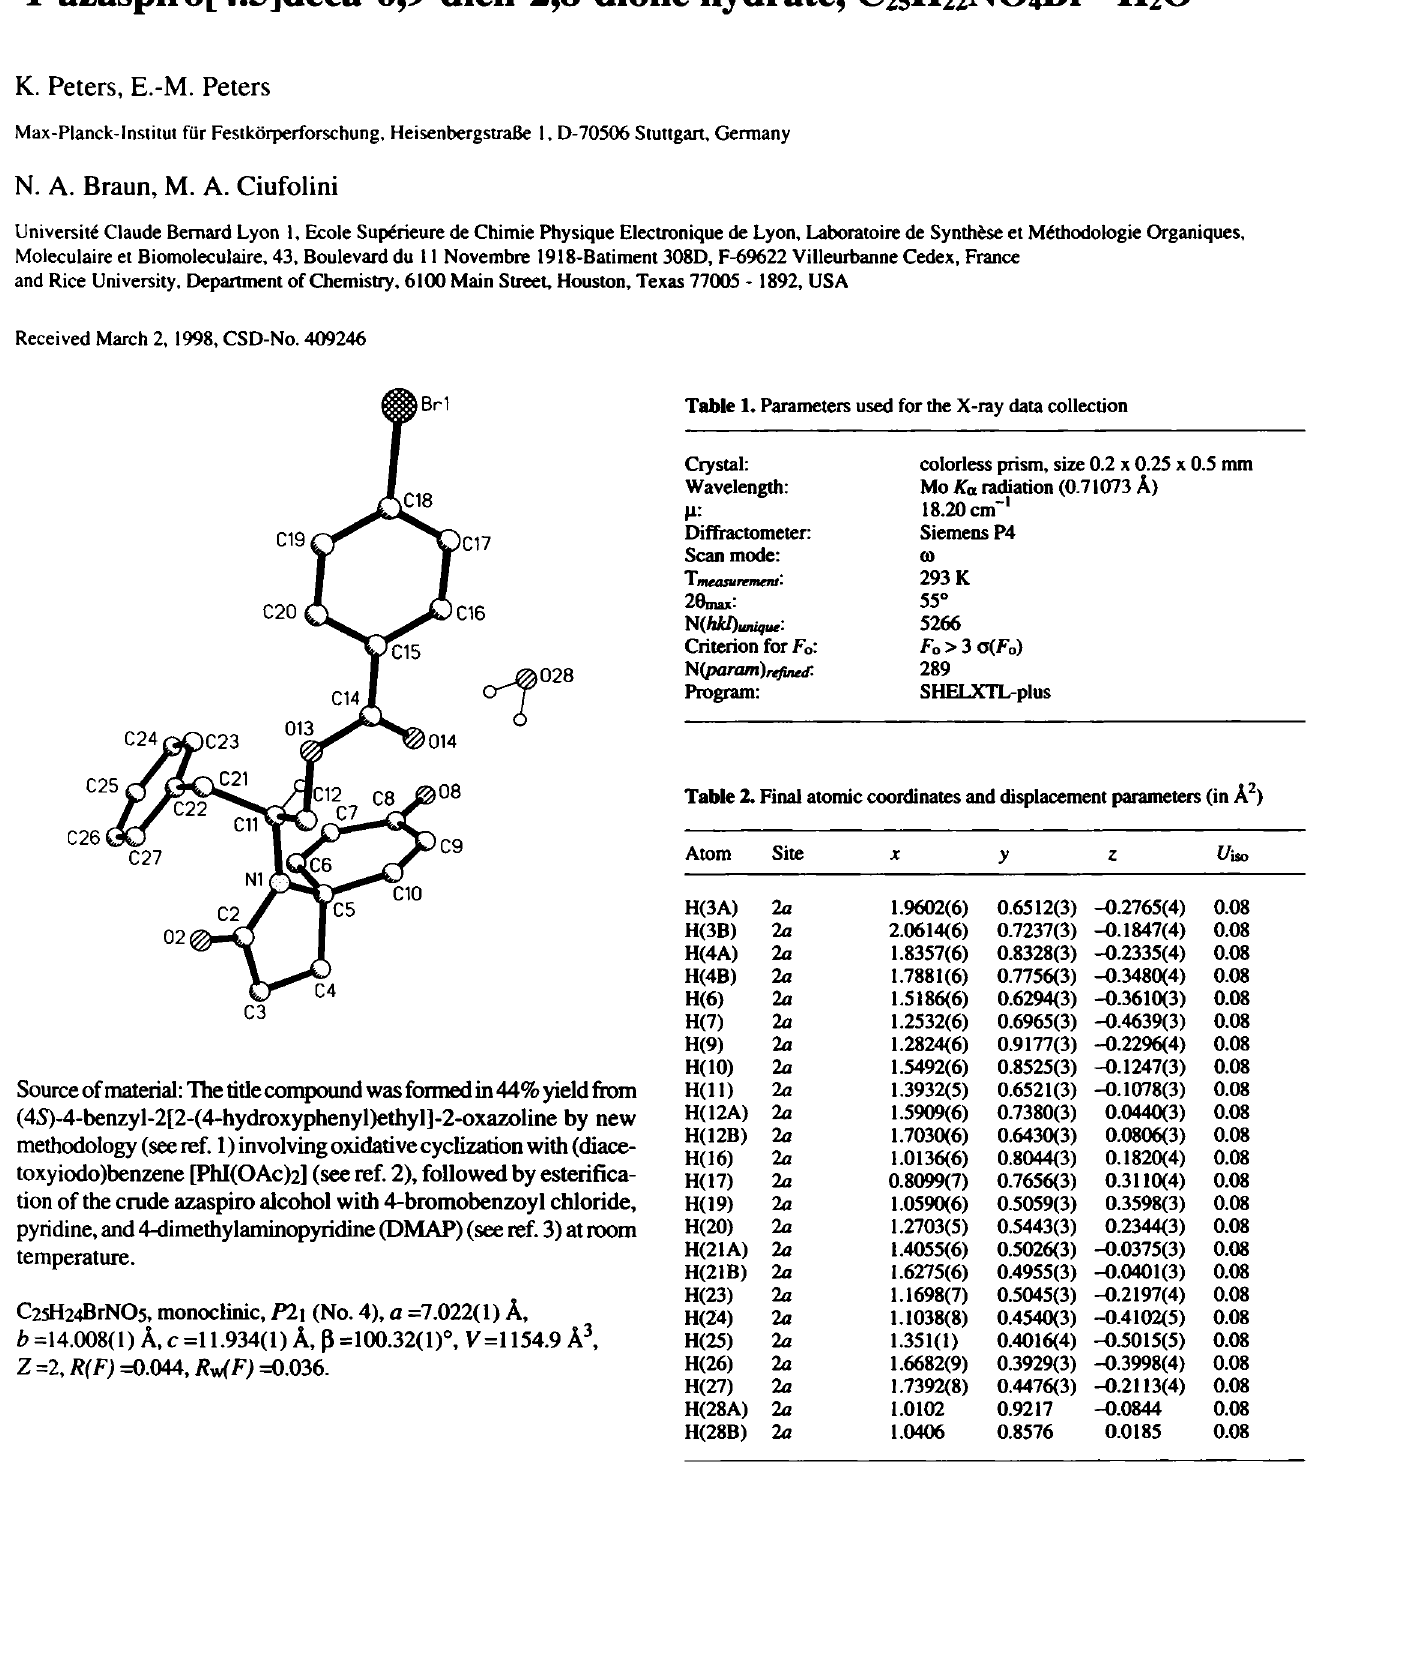
Table 1. Parameters used for the X-ray data collection